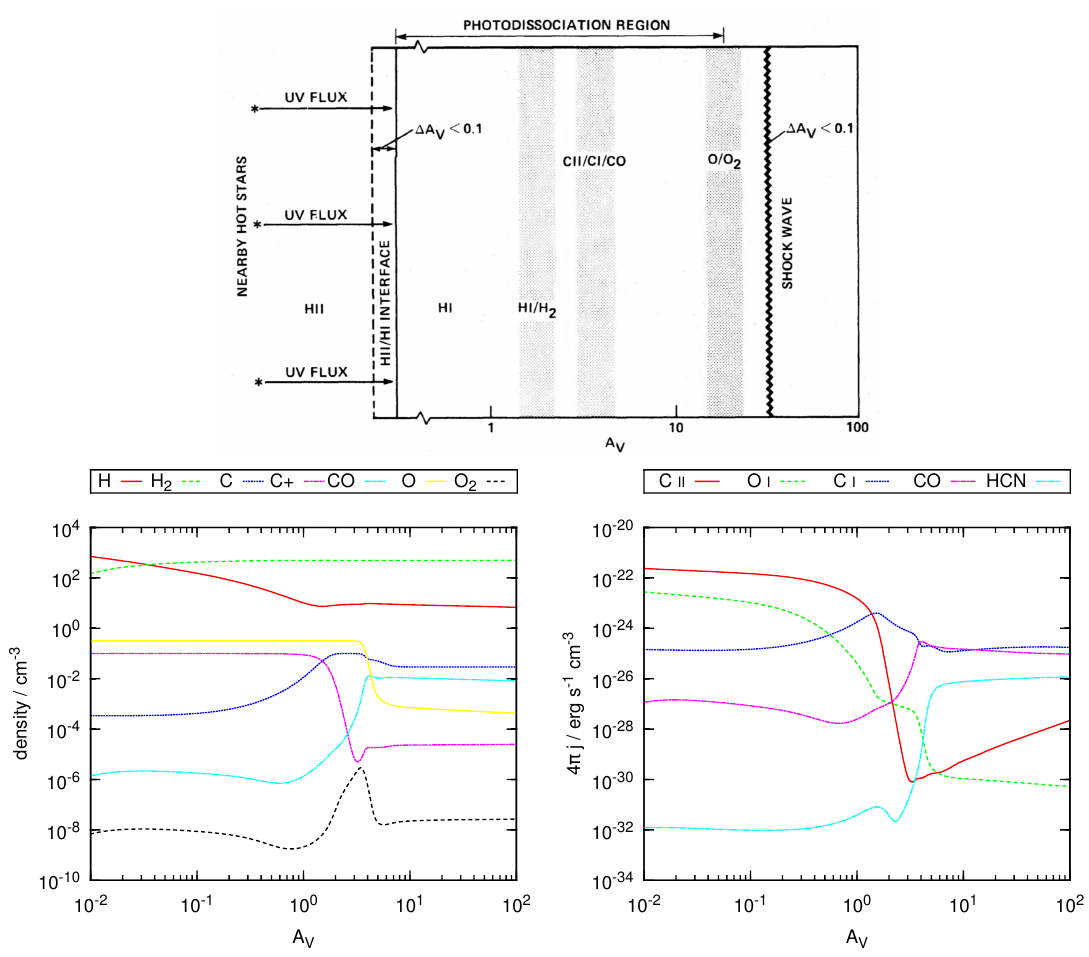
Figure 1. ( Top ) Sketch of standard PDR structure, from innovative work in the 80’s [4] [©AAS. Reproduced with permission]. ( Bottom ) For comparison, an example of PDR structure computed this year with version C17 of C LOUDY [13] for model V1 of [14], adapted to extend to A V = 100. ( Left panel ) Densities of important atoms and molecules in the PDR. ( Right panel ) Local emissivities for some of the most important